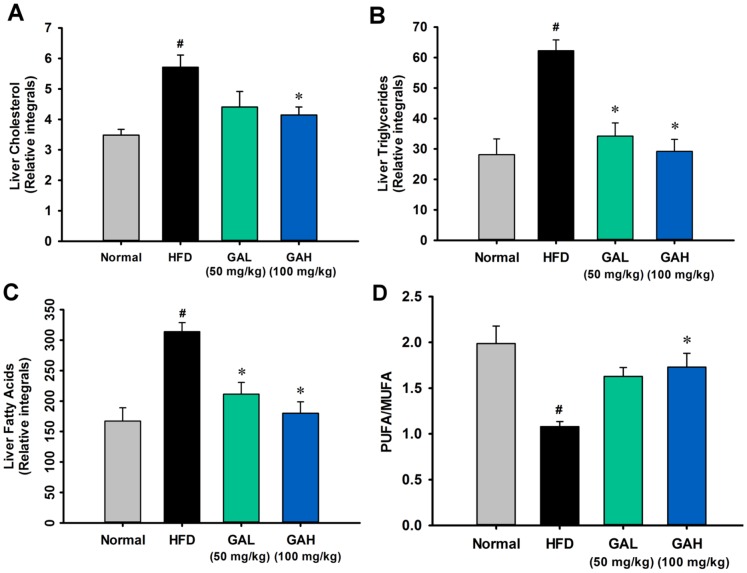
GA Gallic acid (GA) reduced liver lipid accumulation in high-fat diet-fed mice.(A) Liver cholesterol; (B) Liver triglyceride; (C) Liver fatty acids; (D) PUFA/MUFA ratio. The relative integrals of the liver cholesterol, liver triglyceride and liver fatty acids were calculated from the spectral regions at δ 0.670−0.695 for liver cholesterol (C18-H3), at δ 4.120−4.170 for liver triglyceride (Glycerol (C1-Hu) and (C3-Hu)) and at δ 0.81−0.93 for methyl groups of all fatty acids (−CH3). The PUFA-to-MUFA ratio was calculated from the spectral regions at δ 5.29−5.44 for UFA (−CH = CH−), at δ 2.73−2.88 for PUFA (−C = C−CH2−C = C−) and at δ 0.81−0.93 for methyl groups of all fatty acids (−CH3) [33]. The data are presented as the mean ± SEM. #p<0.05, versus normal diet mice; *p<0.05, versus high fat diet-fed mice. The relative integrals were normalized against the weight of the wet tissue used for liver the extract.